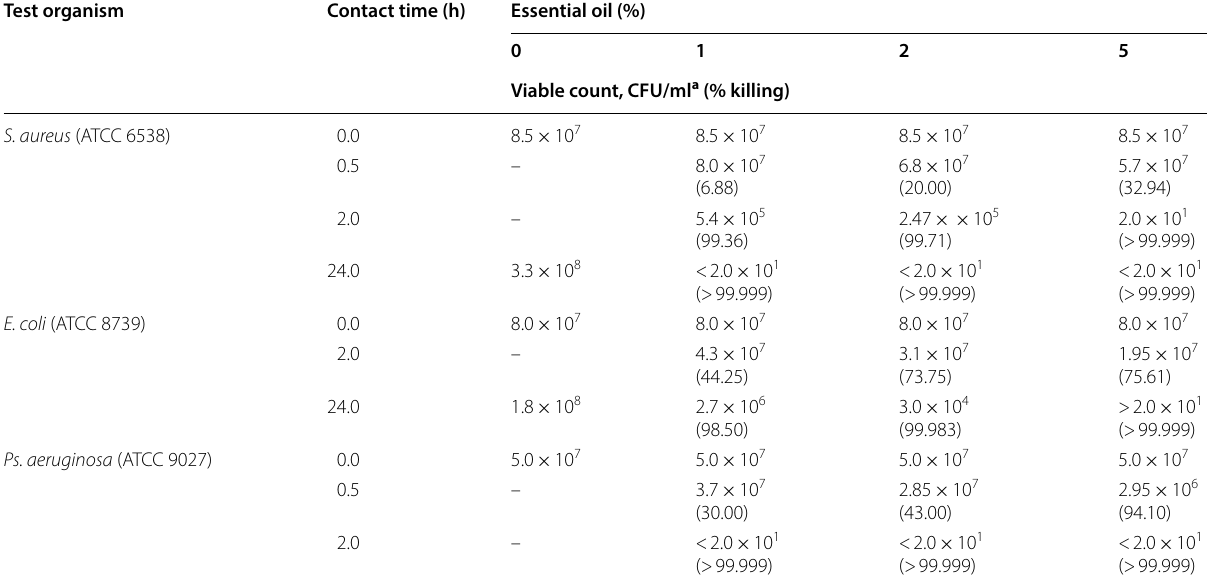
a Average of three determinations carried out by surface viable count method at RT (24 °C)